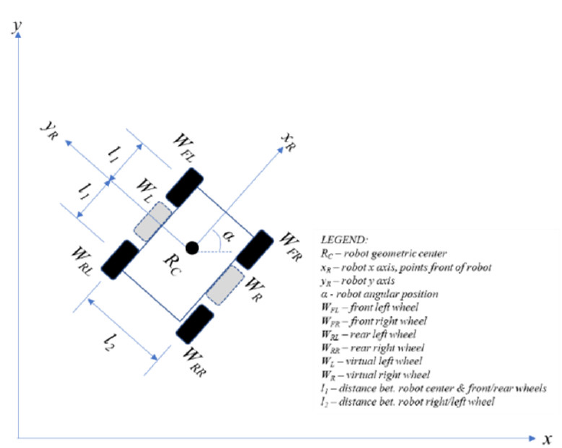
Figure 7. Robot ′ s kinematics to determine its current position.